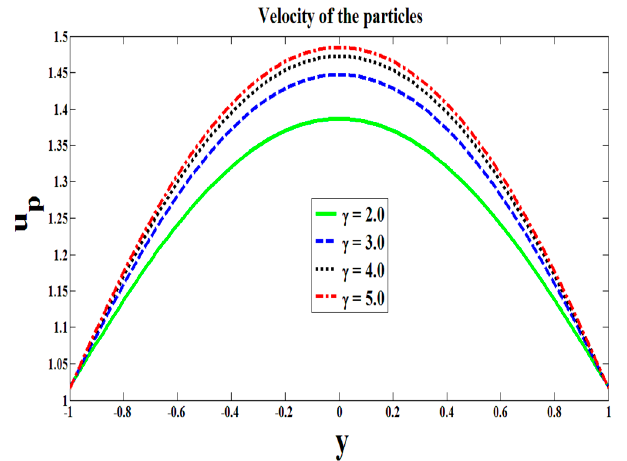
Figure 7. Couples stress parameter affecting the motion of particles.